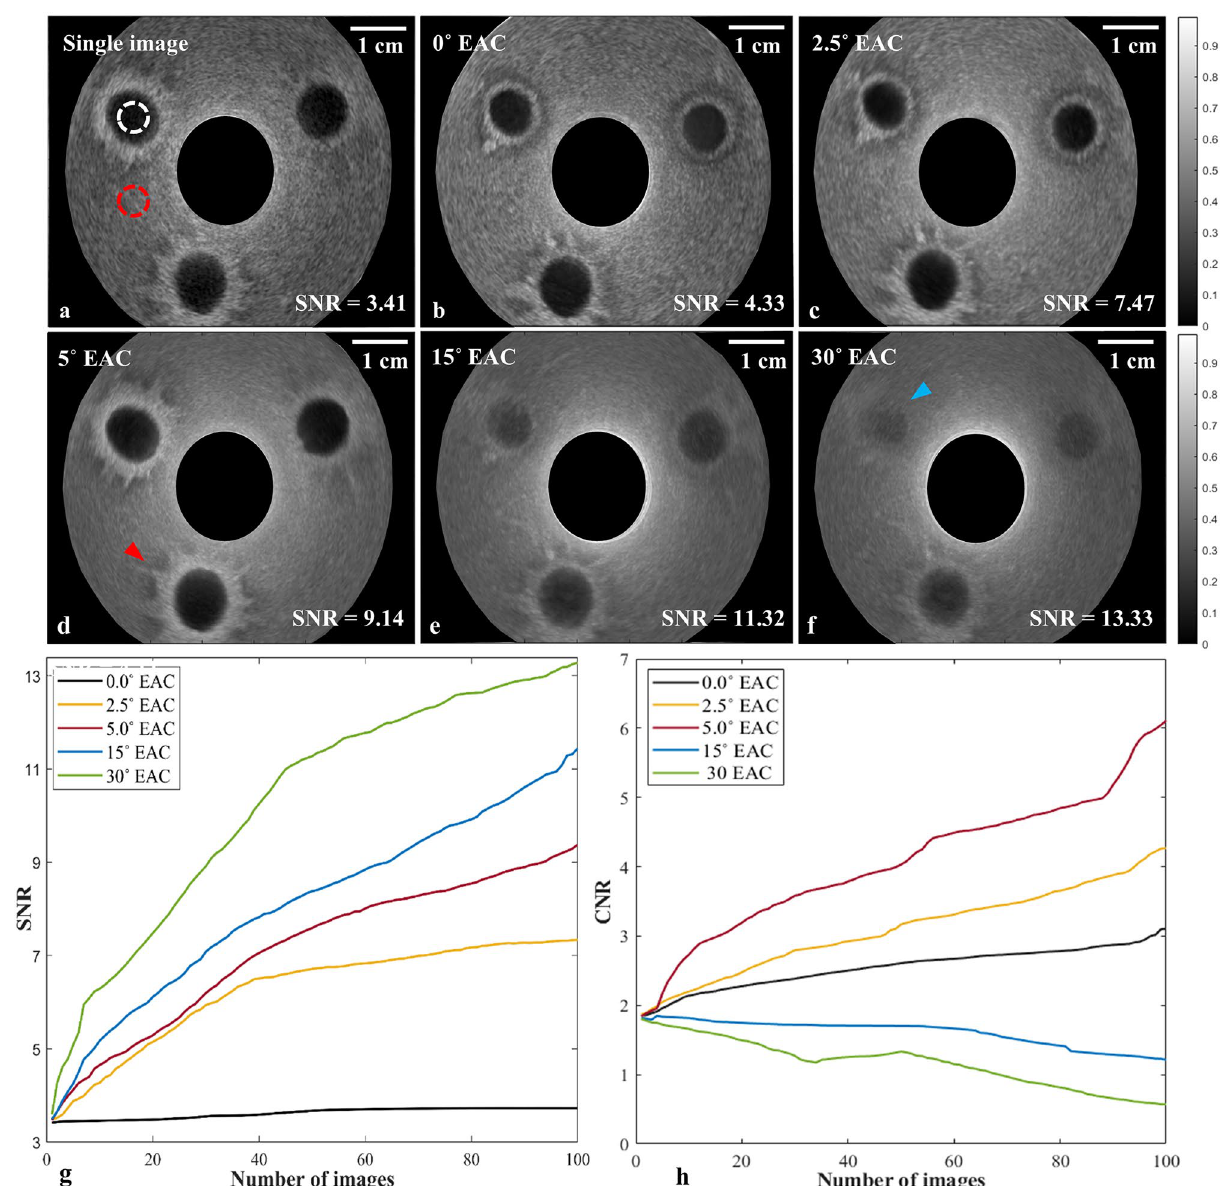
Figure 3. The effect of elevational angular deflection on speckle reduction efficiency and image fidelity in REACT. (a) A single US image of a single-layered cylindrical phantom (Phantom B) containing spherical water beads to mimic lymph nodes. The white dotted circles indicate the ROIs used to derive the SNR and CNR. (b–f) Compounded images of Phantom B using five different cylindrical acoustic lenses with the following angular deflections: (b) 0°, (c) 2.5°, (d) 5°, (e) 15°, (f) 30°. The red arrow in d depicts fine structures, which are best resolved by 5° EAC. The blue arrow in f indicates a water bead that is barely visible due to loss of image fidelity at 30° EAC. (g,h) The change in SNR and CNR for each deflection angle with increasing number of compounded